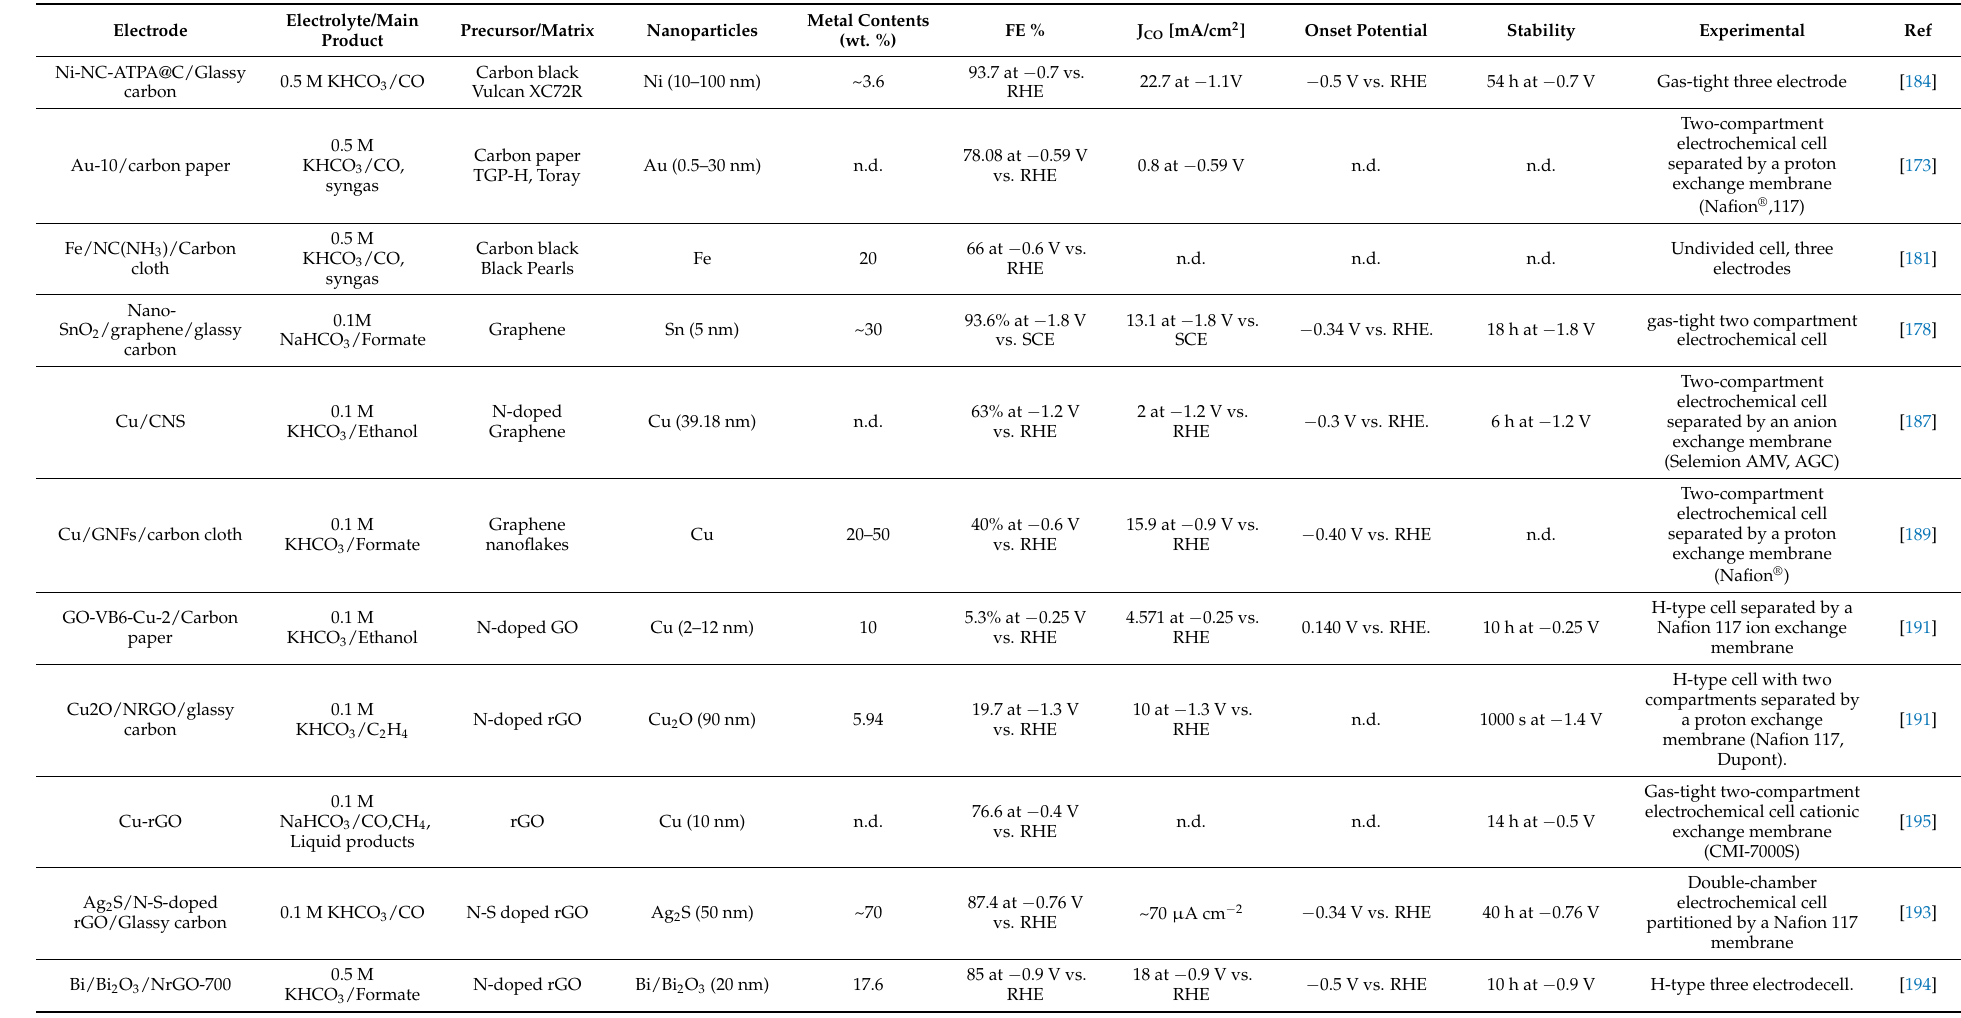
Table 8. Synthesis of metal nanoparticles supported on carbon-based materials and electrochemical